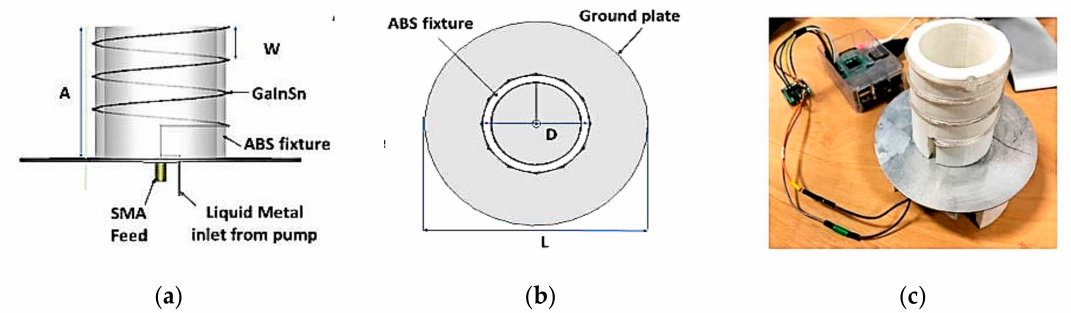
Figure 29. The proposed antenna in [39]: ( a ) side view, ( b ) top view, and ( c ) antenna prototype.